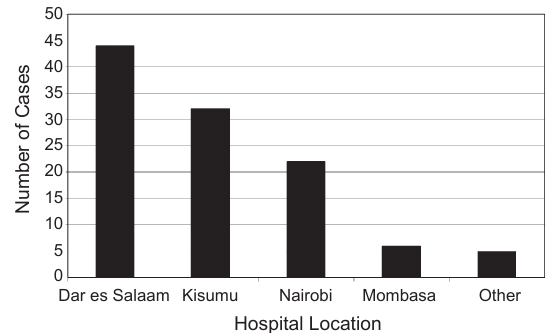
Fig. 2. Number of cases posted based on hospital of origin. The “Other” category refers to cases for which glass slides were sent by a referring hospital to one of the four participating institutions that had the telepathology equipment available for image capture and